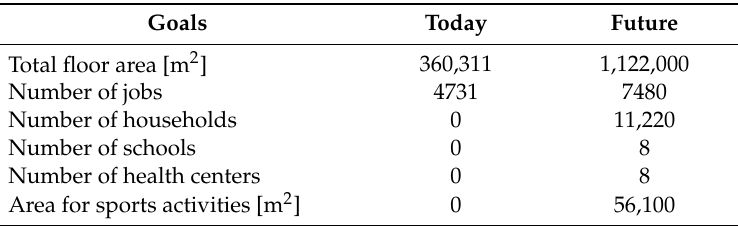
Table 8. Overview of some goals envisioned by the Municipality of Amsterdam for “Sloterdijk One” by the year 2040. Source: